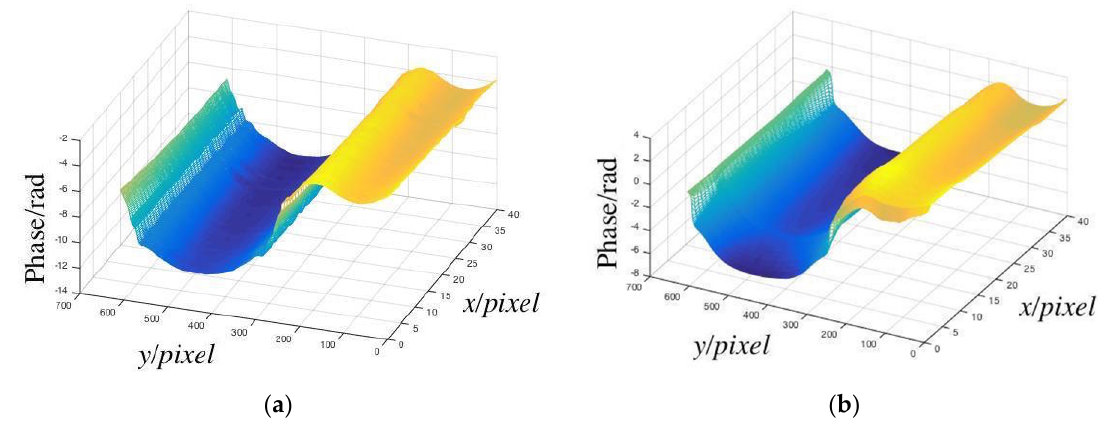
Figure 12. ( a ) Calabash’s phase distribution calculated by machine learning; ( b ) calabash’s phase distribution calculated by FFT.